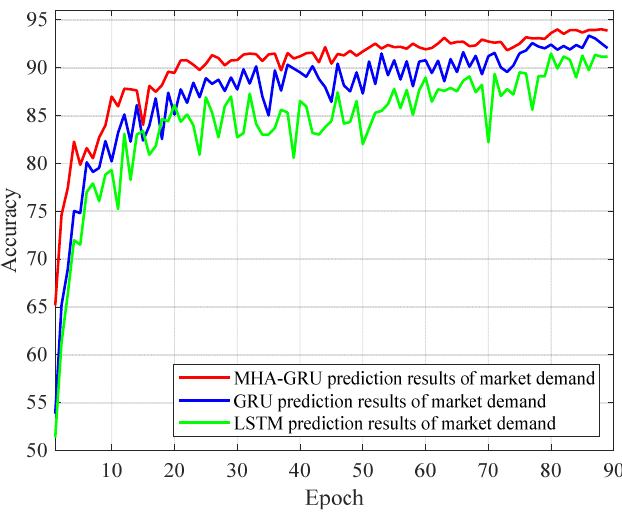
Figure 14 illustrates the accuracy curves of MHA-GRU, GRU, and LSTM predictions. Apparently, the MHA-GRU model provides a better accuracy of prediction for the series, as it has superior fitting and prediction accuracy. Predicting the short-term tendency of client volume can significantly help supply chain managers make good commercial choices, increase management effectiveness, and become more responsive to market changes.